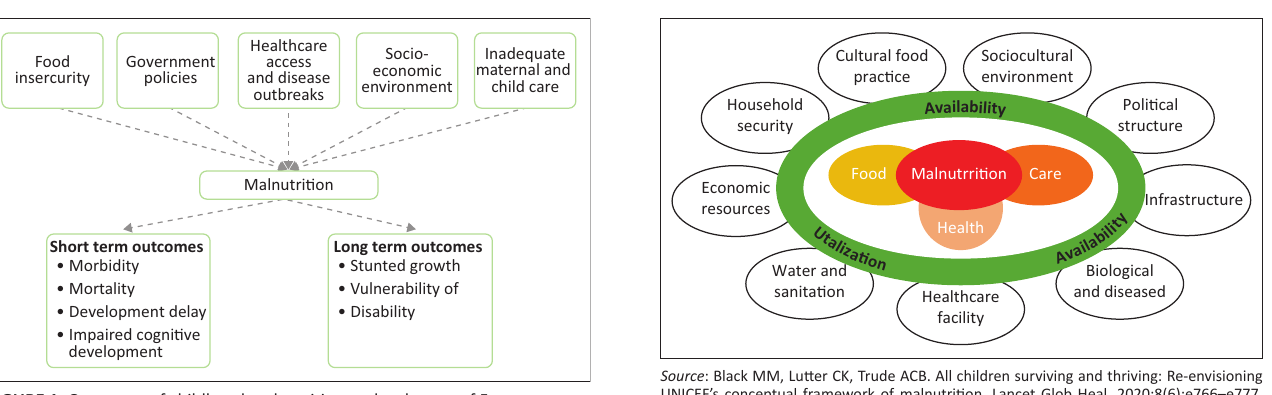
FIGURE 2: Theatrical framework for causes of malnutrition in children under the age of 5